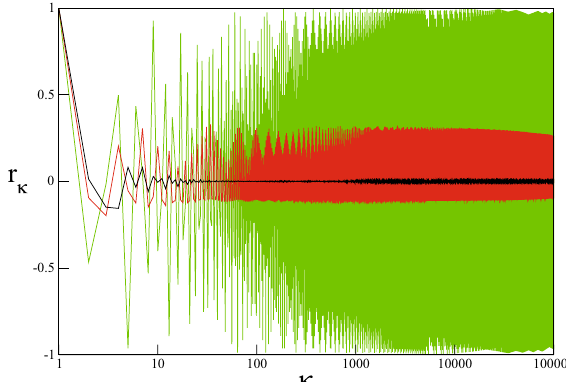
Figure 12. Auto-correlation functions of data points obtained for initial conditions selected from the stability island (green) and the chaotic sea (red and black) of the ( W = 3 , K = 0.6 )